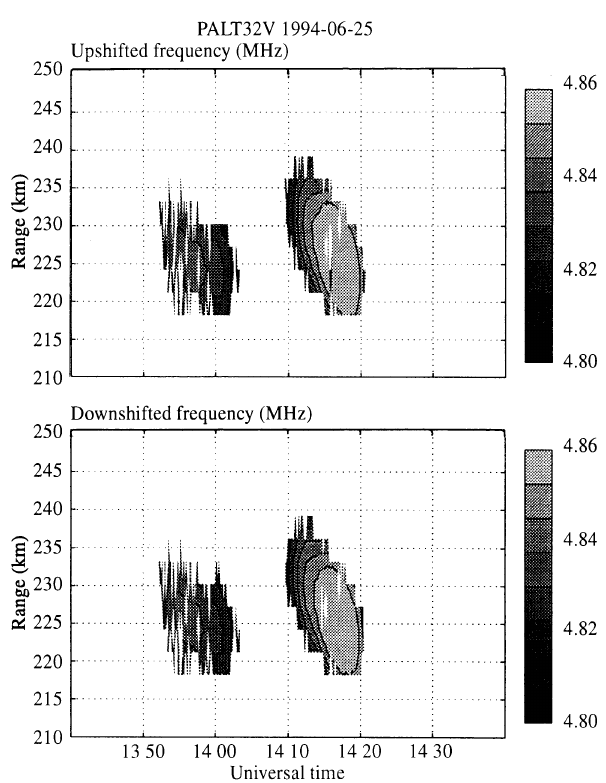
Fig. 6. The fitted upshifted and downshifted received frequencies displayed as a function of range and time for the Gaussian model